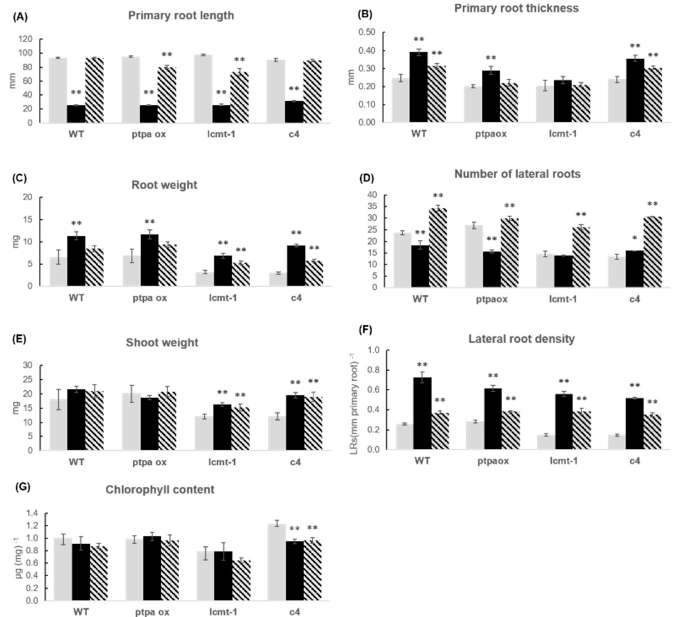
Figure 8. Growth parameters of WT and mutants influenced by A. brasilense . Growth parameters of WT and mutants ptpa ox , lcmt1 , c4 cultivated without bacteria (grey bars), with A. brasilense Sp245 (black bars) and with A. brasilense FAJ0009 (hatched bars) for two weeks. ( A ) primary root length; ( B ) primary root thickness; ( C ) root fresh weight; ( D ) number of lateral roots; ( E ) shoot fresh weight; ( F ) lateral root density; and ( G ) chlorophyll content. For root length, primary root thickness, number of lateral roots, and root density, data are means ± SE of 30 plants ( n = 30). For fresh weight and chlorophyll content, the plants in each plate were pooled for measurements, and data given is the average of six independent experiments, n = 6, ±SE is given. The root and shoot weights ( C , E ) represent single plant averages. The chlorophyll values ( G ) represent µg chlorophyll per mg leaf tissue. According to Student’s t -test and p -value < 0.05, columns marked with two asterisks are significantly different from the control without bacteria, and for one asterisk with p < 0.1.